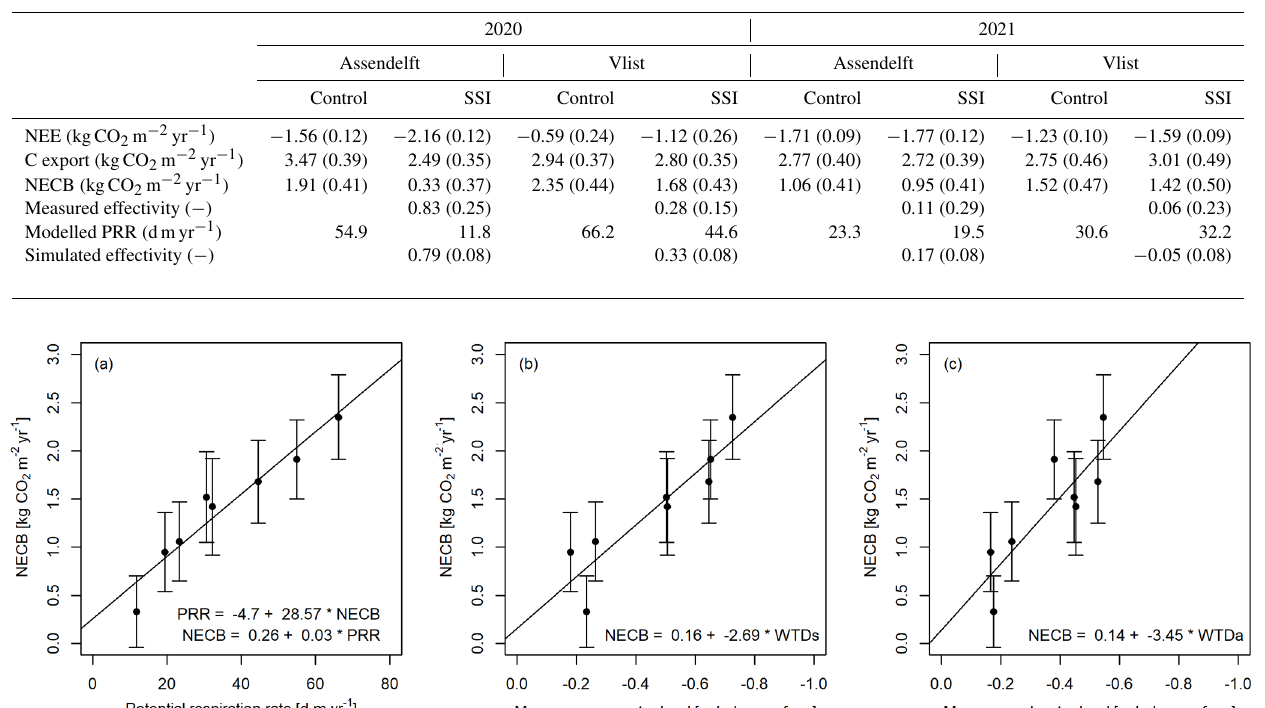
Table 2. Measured carbon balance in the growing season with corresponding effectivity of water management strategies and modelled potential respiration rate for each measurement location with simulated effectivity of water management strategies.